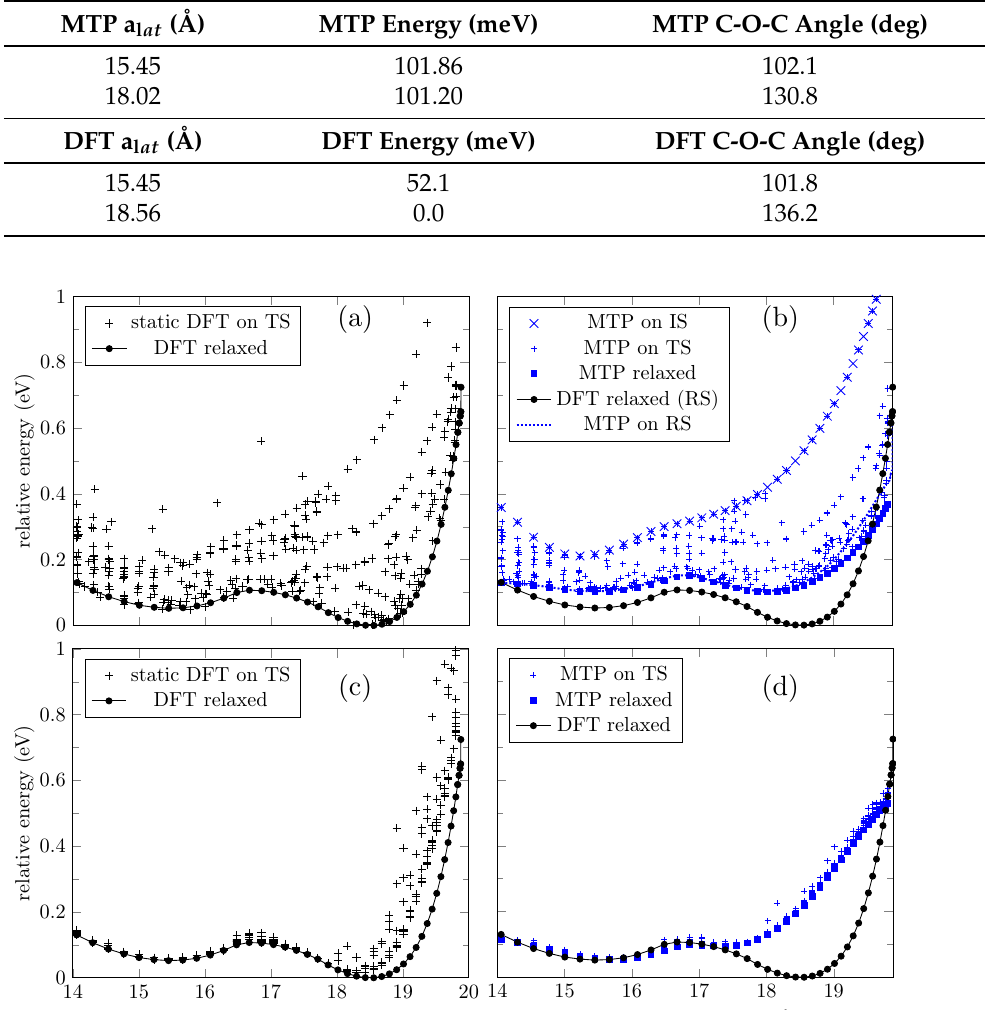
Table 1. Energies and angles for the two minima obtained with the MTP and DFT: initial calculations.